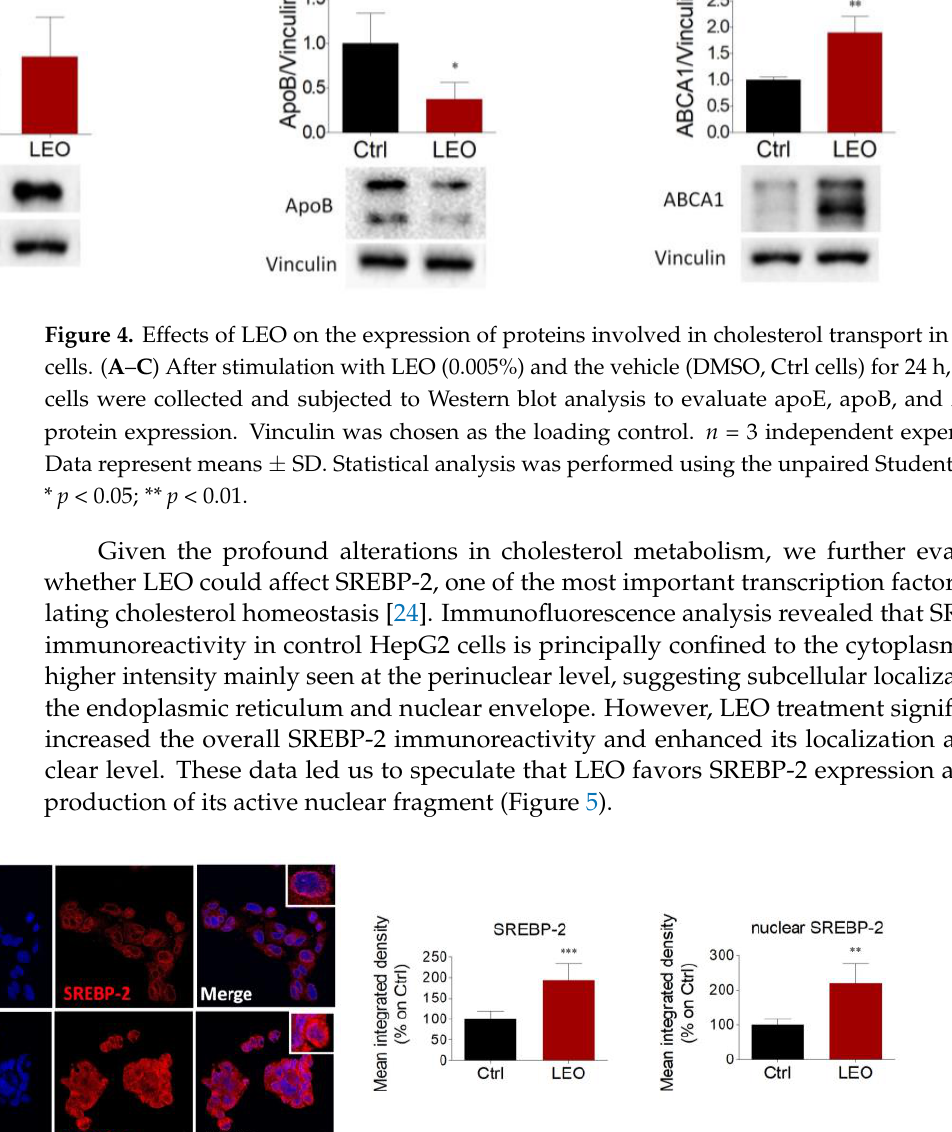
(right panel) was calculated to evaluate the protein co-localization . n = 7 different experiments. Data represent means ± SD. Statistical analysis was assessed using the unpaired Student’s t -test. ** * p < 0.001.